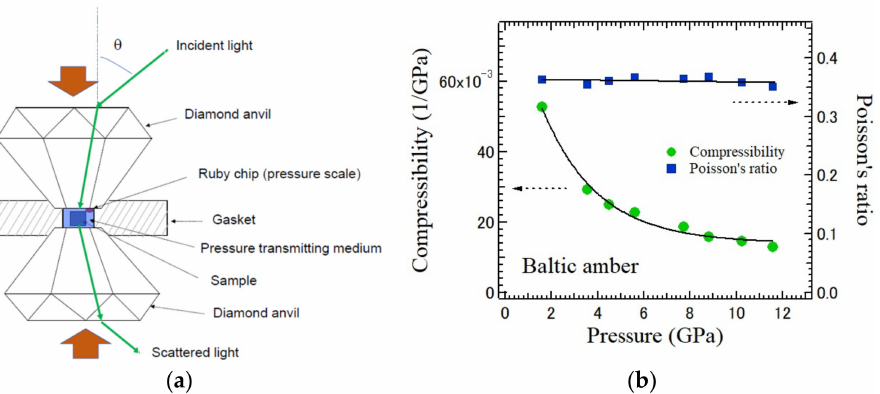
Figure 5. ( a ) Brillouin scattering experiment at high pressures using a diamond anvil cell. ( b ) Pressure dependences of compressibility and Poisson’s ratio of the Baltic amber measured by Brillouin scattering